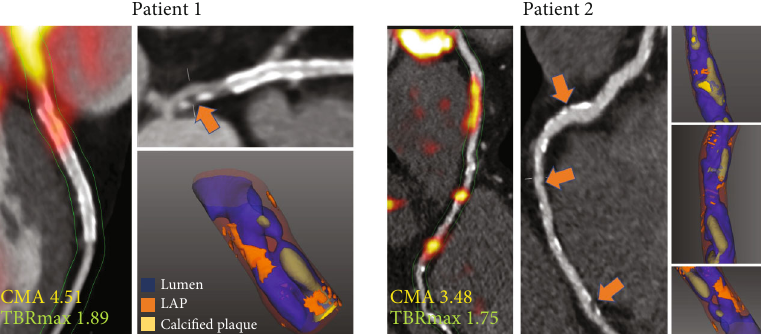
Figure 3: Case examples of coronary 18 F-sodium fl uoride uptake. Low attenuation plaque (LAP) on CT angiography and LAP (orange arrows) on 3D CT rendering. Right (Patient 1) and left anterior descending (Patient 2) coronary arteries. Areas of LAP correspond with areas of increased 18 F-NaF activity. While maximum target-to-background ratio (TBRmax) re fl ects single hotspot activity, coronary microcalci fi cation activity (CMA) values represent the whole-vessel 18 F-sodium fl uoride burden. Reprinted by permission from Springer Nature: EJNMMI (Kwiecinski et al. [61]).